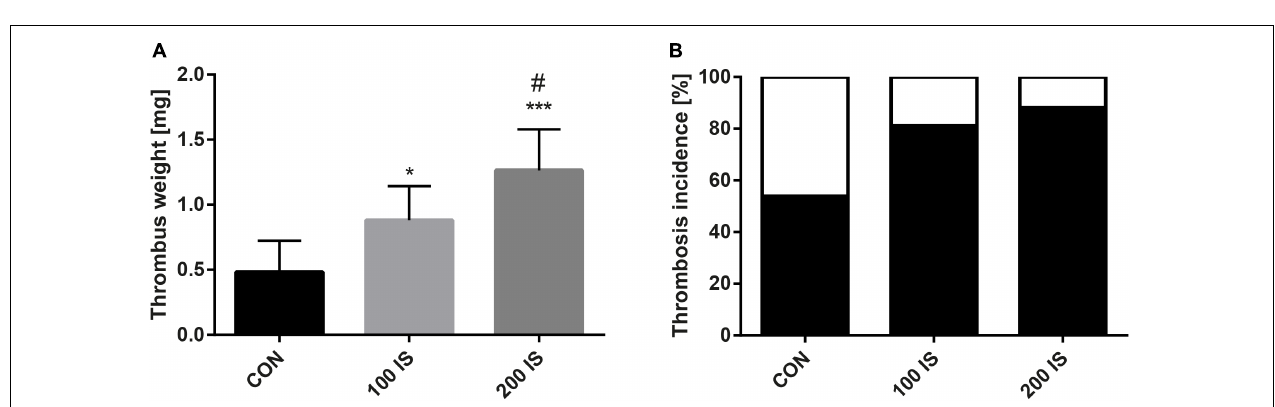
FIGURE 1 | The plasma (A) and urine (B) concentrations of IS after chronic administration. Data are presented as the mean ± SD or median (full range) depending on their distribution. CON, control group; 100 IS, group receiving IS in the dose of 100 mg/kg b.w./day; 200 IS, group receiving IS in the dose of 200 mg/kg b.w./day; IS, indoxyl sulfate; ∗∗∗ p < 0.001 compared to control; ### p < 0.001 compared to 100 IS group.